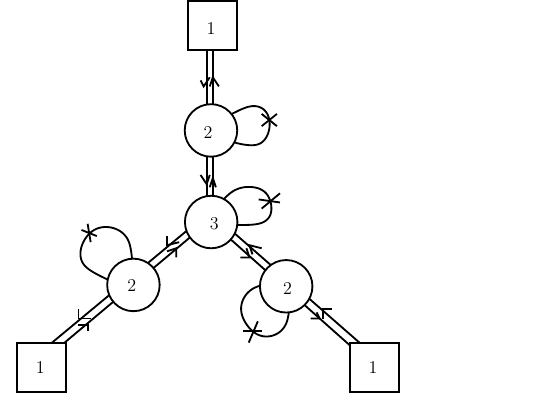
Figure 33 . The Dynkin diagram of E 6 (cid:2) E 6 with the shaded node corresponding to the node with the (cid:13)ux.